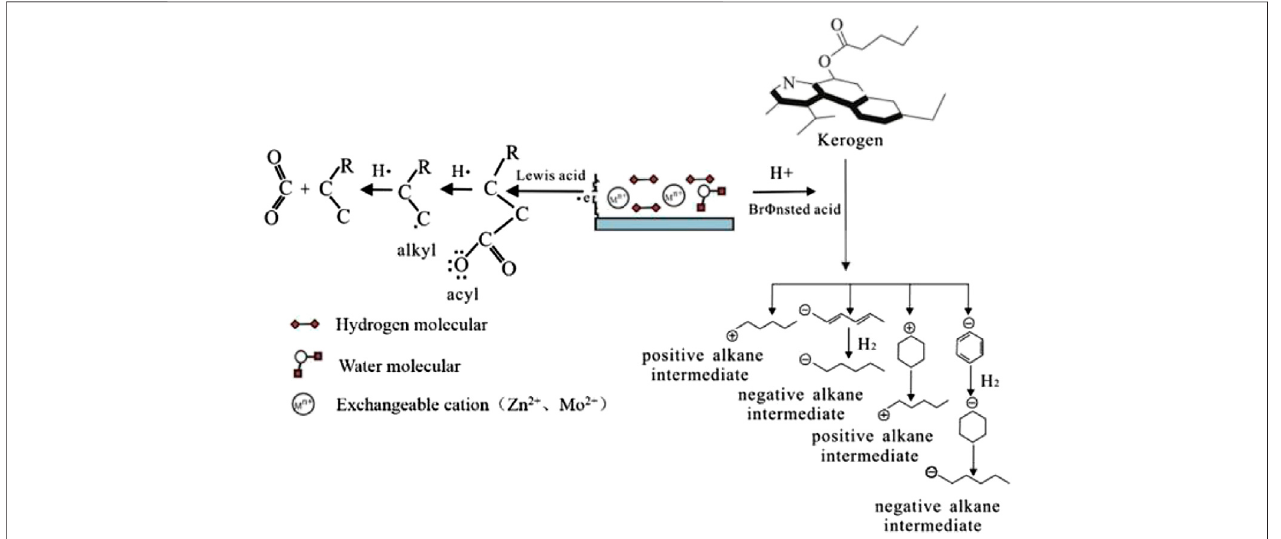
FIGURE 9 | Catalytic mechanism of transition metal based on free radical cracking and H ion reaction (modi fi ed according to Johns, 1979; Mango et al, 1994; Mango, 1996; He et al., 2011; Wu et al., 2012; Ma et al., 2018).